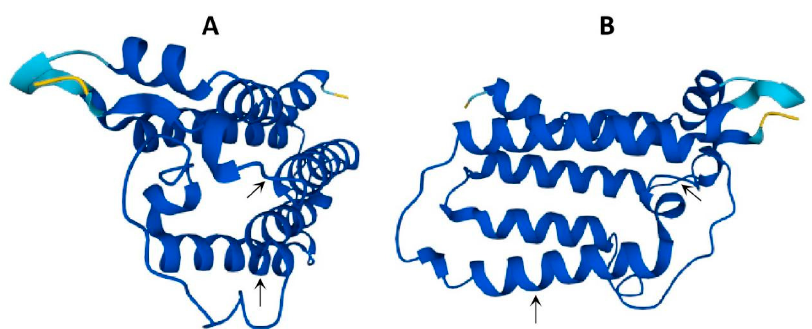
Figure 4. Tertiary structure of soybean GmPLMT shown in XY plan ( A ) and XZ plan ( B ) predicted by